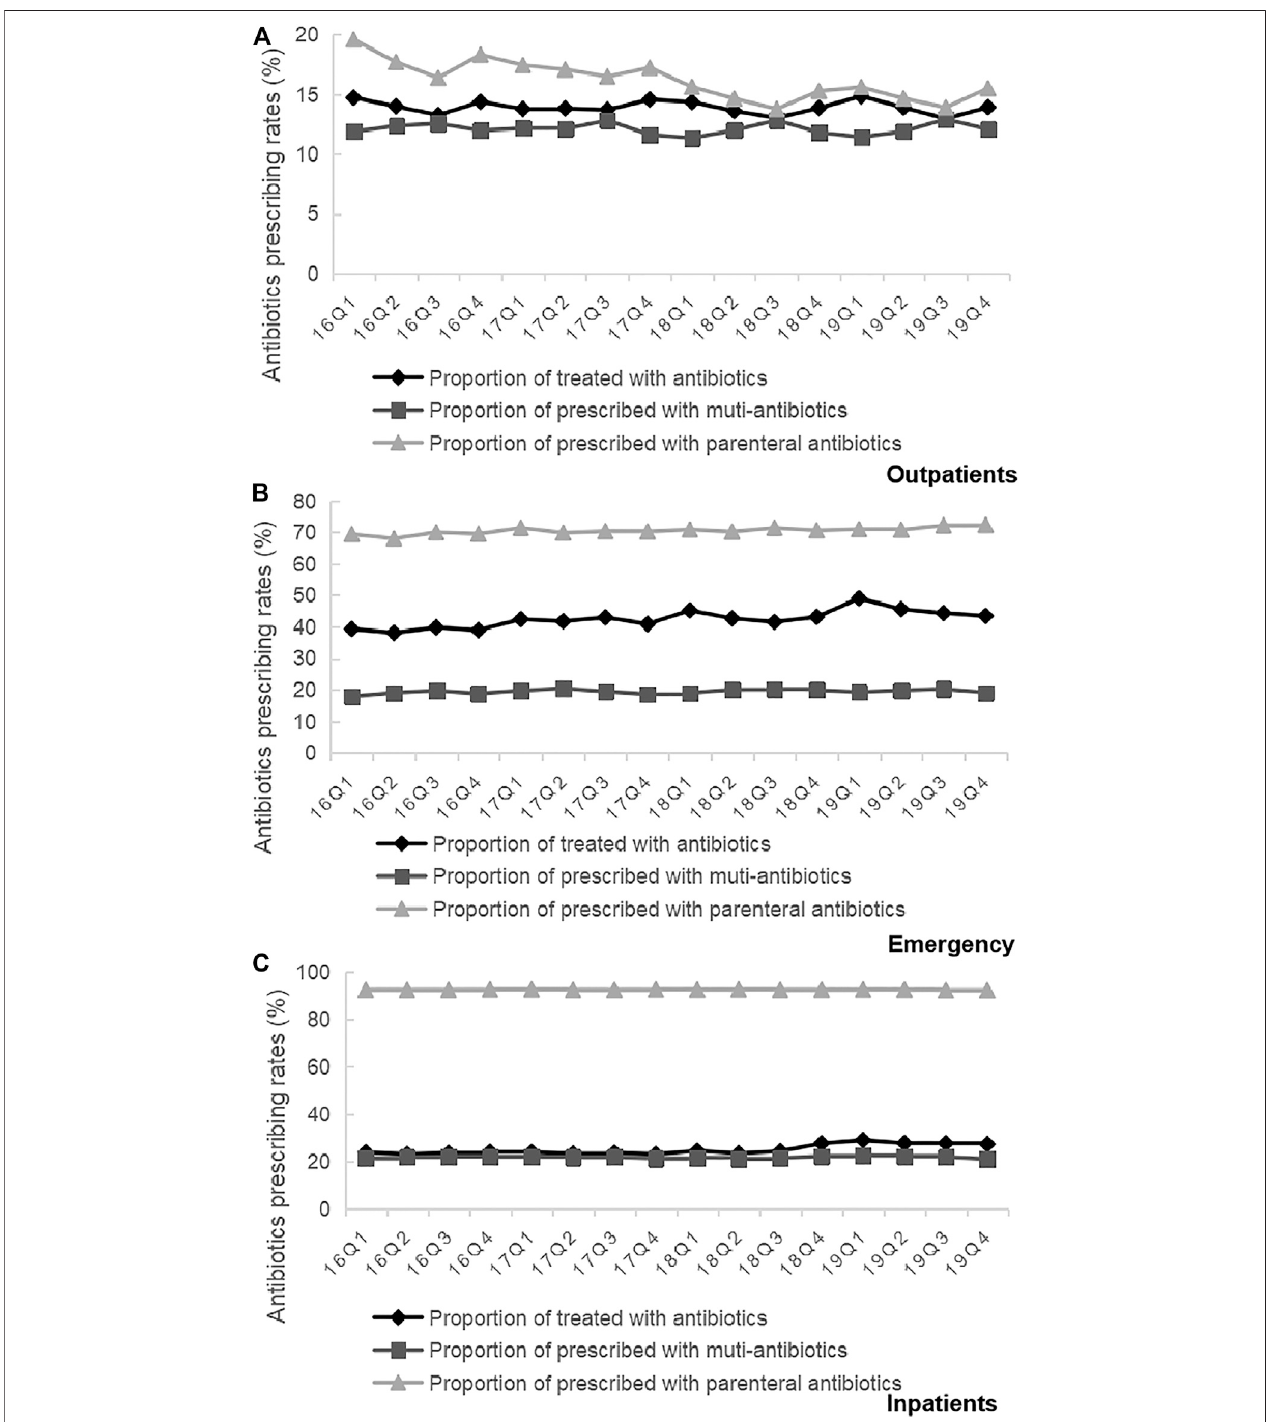
FIGURE3|(A) ChangesinantibioticsprescribingratesinOutpatients,2016 – 19. (B) ChangesinantibioticsprescribingratesinEmergency,2016 – 19. (C) Changes in antibiotics prescribing rates in Inpatients, 2016 – 19.